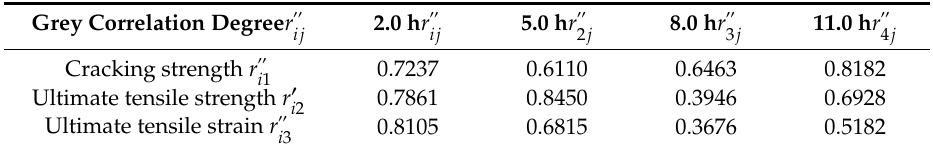
Table 8. Grey correlation degrees of the durations of vibration on the tensile performance of PVA-ECC during the period between the initial set and the final